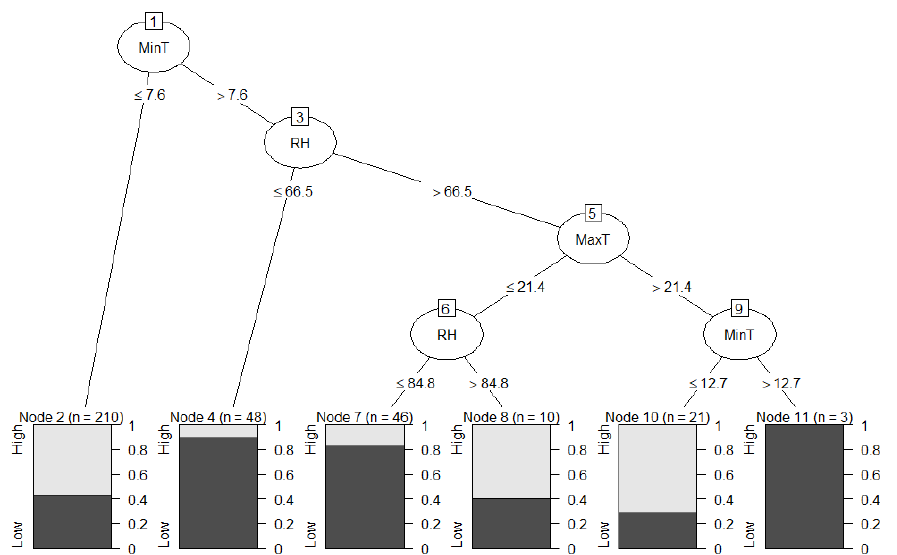
Figure 6. C5.0 model for Pla a 1 allergen developed from the 2009 – 2020 dataset. Terminal nodes indicate the classification of cases based on percentage represented in dark grey (moderate pollen) or light grey (high pollen).